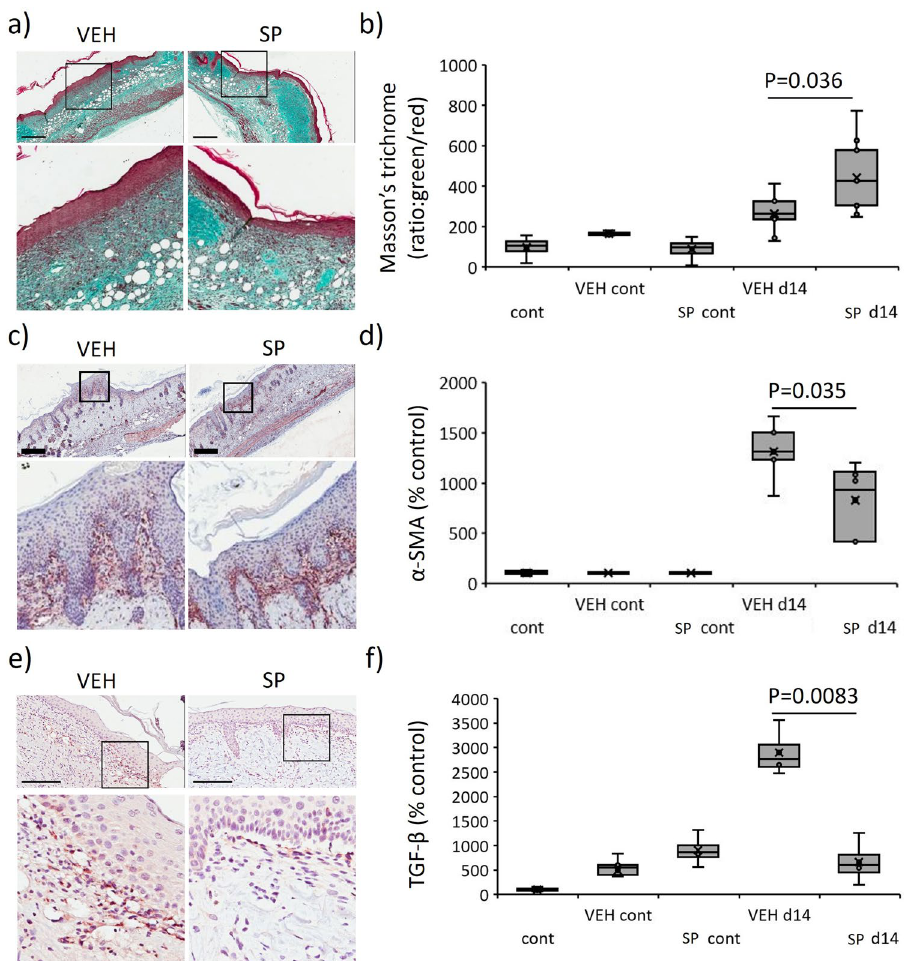
Figure 8. Reduced fibrotic activity in SP-treated pressure injury. Masson’s trichrome representative images ( a ) and quantification ( b ) in mouse pressure injury. α-SMA representative images ( c ) and quantification ( d ) in mouse pressure injury. TGF-β stain representative images ( e ) and quantification ( f ) in mouse pressure injury. Data in ( b , d , f ) presented as a box and whisker plot as ratio of green to red staining ( b ) or total staining intensity per unit area ( d , f ) as a percentage of the unwounded vehicle-treated control. Data were analyzed by two-way ANOVA with Bonferonni post-hoc test, (n = 6 per group). Scale bars = 200